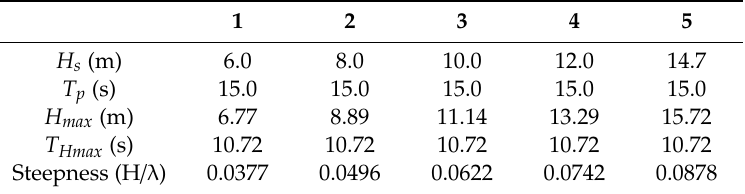
Table 5. Focused wave parameters with incident wave peak period T p = 15.0 s.